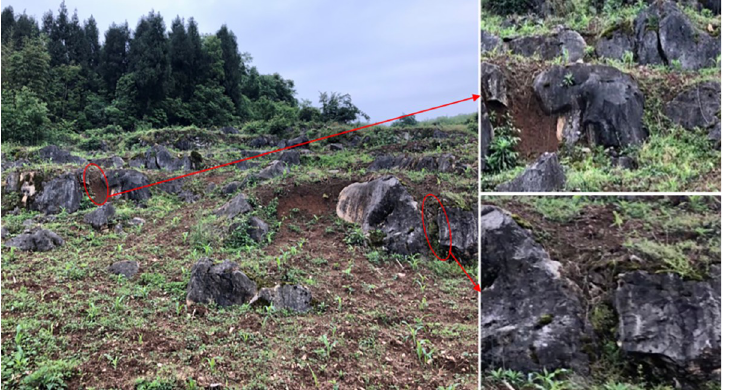
Fig 1. Underground fissure of slope farmland in karst